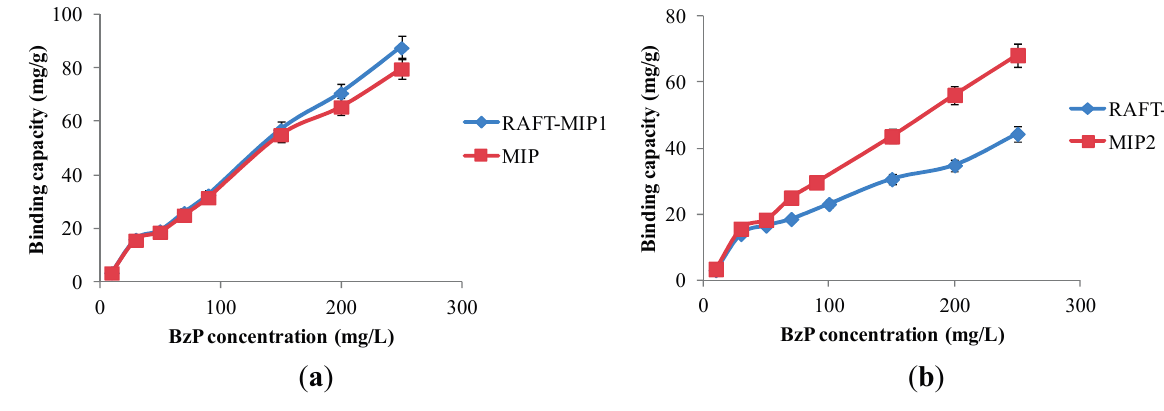
Figure 8. Binding isotherms of ( a ) RAFT-MIP1 and MIP; and ( b ) RAFT-MIP2 and MIP2.